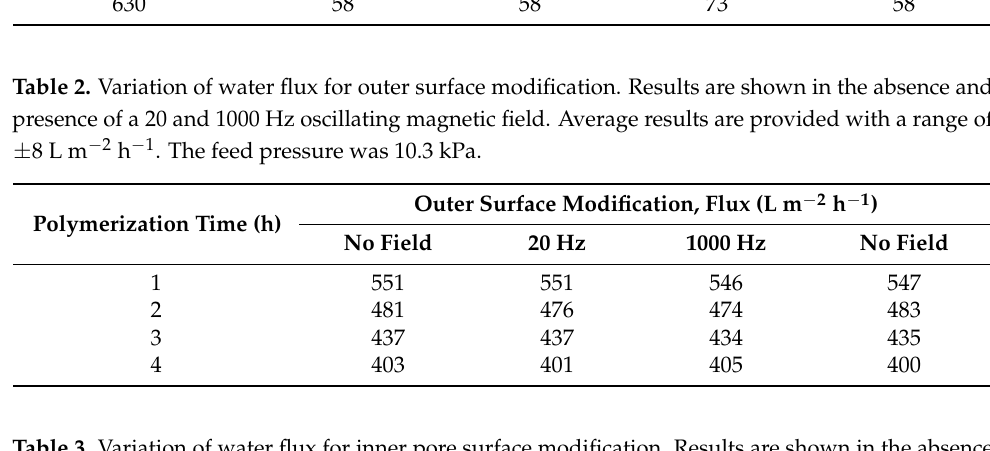
Table 3. Variation of water flux for inner pore surface modification. Results are shown in the absence and presence of a 20 and 1000 Hz oscillating magnetic field. Average results are provided with a range of ± 8 L m − 2 h − 1 . The feed pressure was 10.3